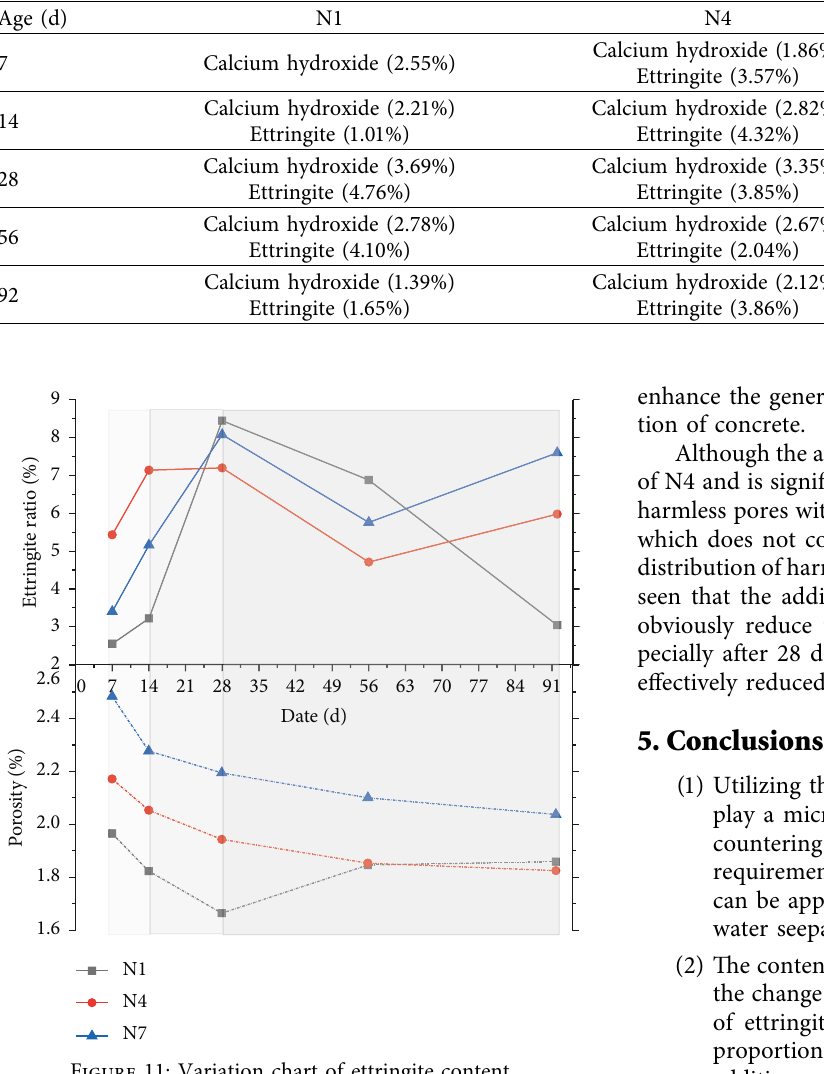
Table 7: Specimens’ XRD analyses results with different ratios and ages.